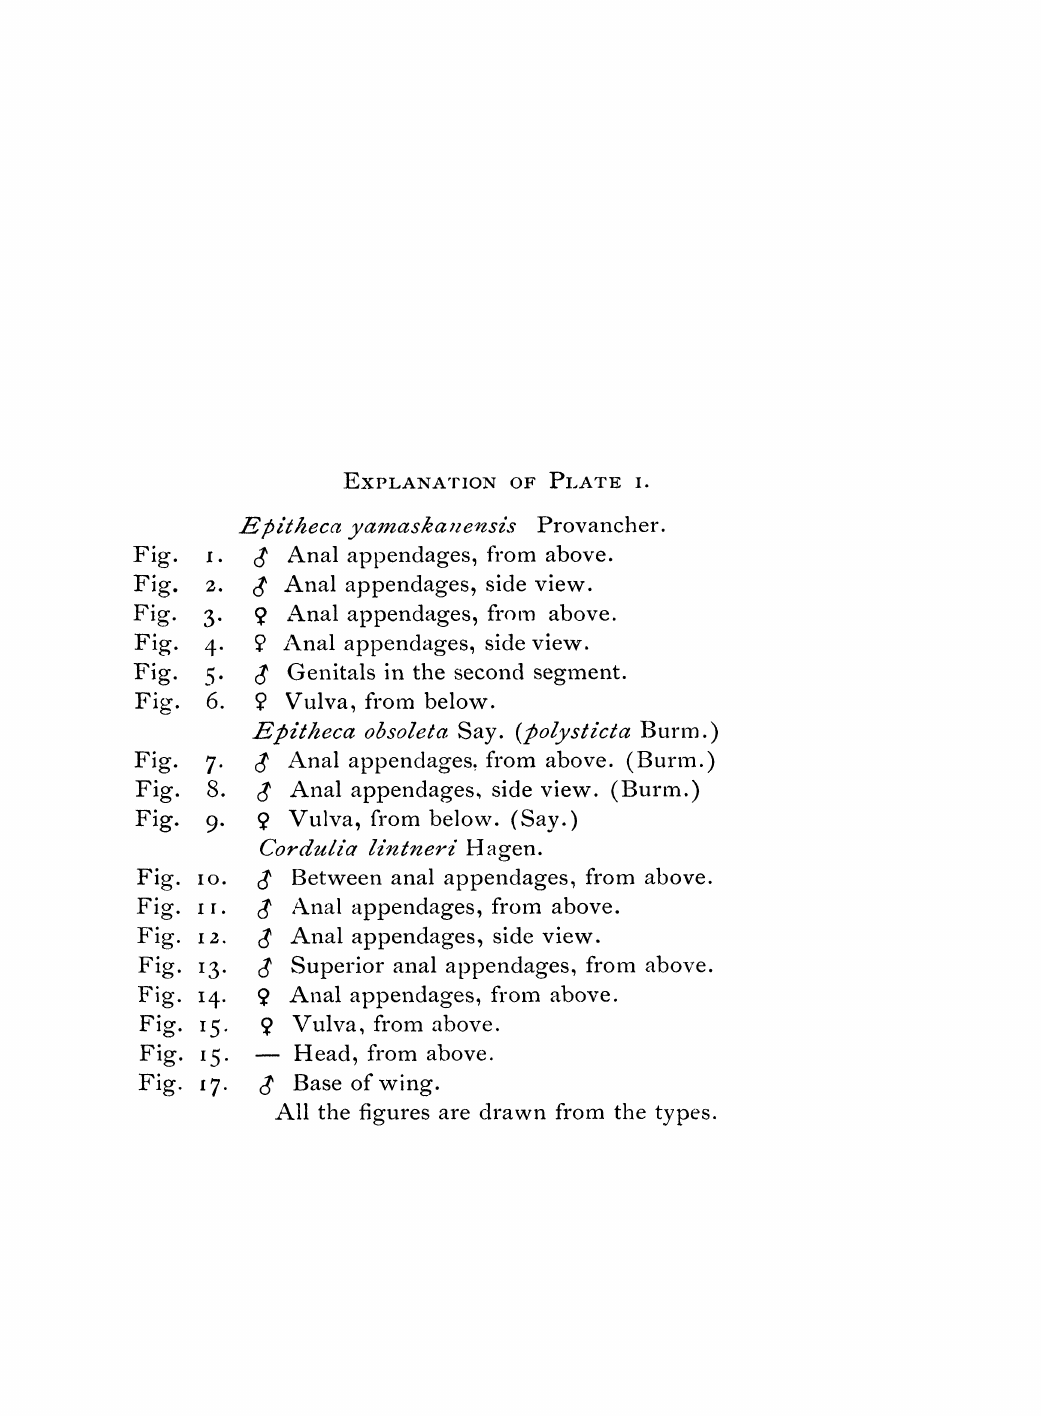
. Fig. Fig. z. Fig. 3. Fig. 4- Fig. 5" Fig. 8. Fig. 9. Fig. to. Fig. Fig. Fig. t3. Fig. 14. Fig. Fig. 15. Fig.